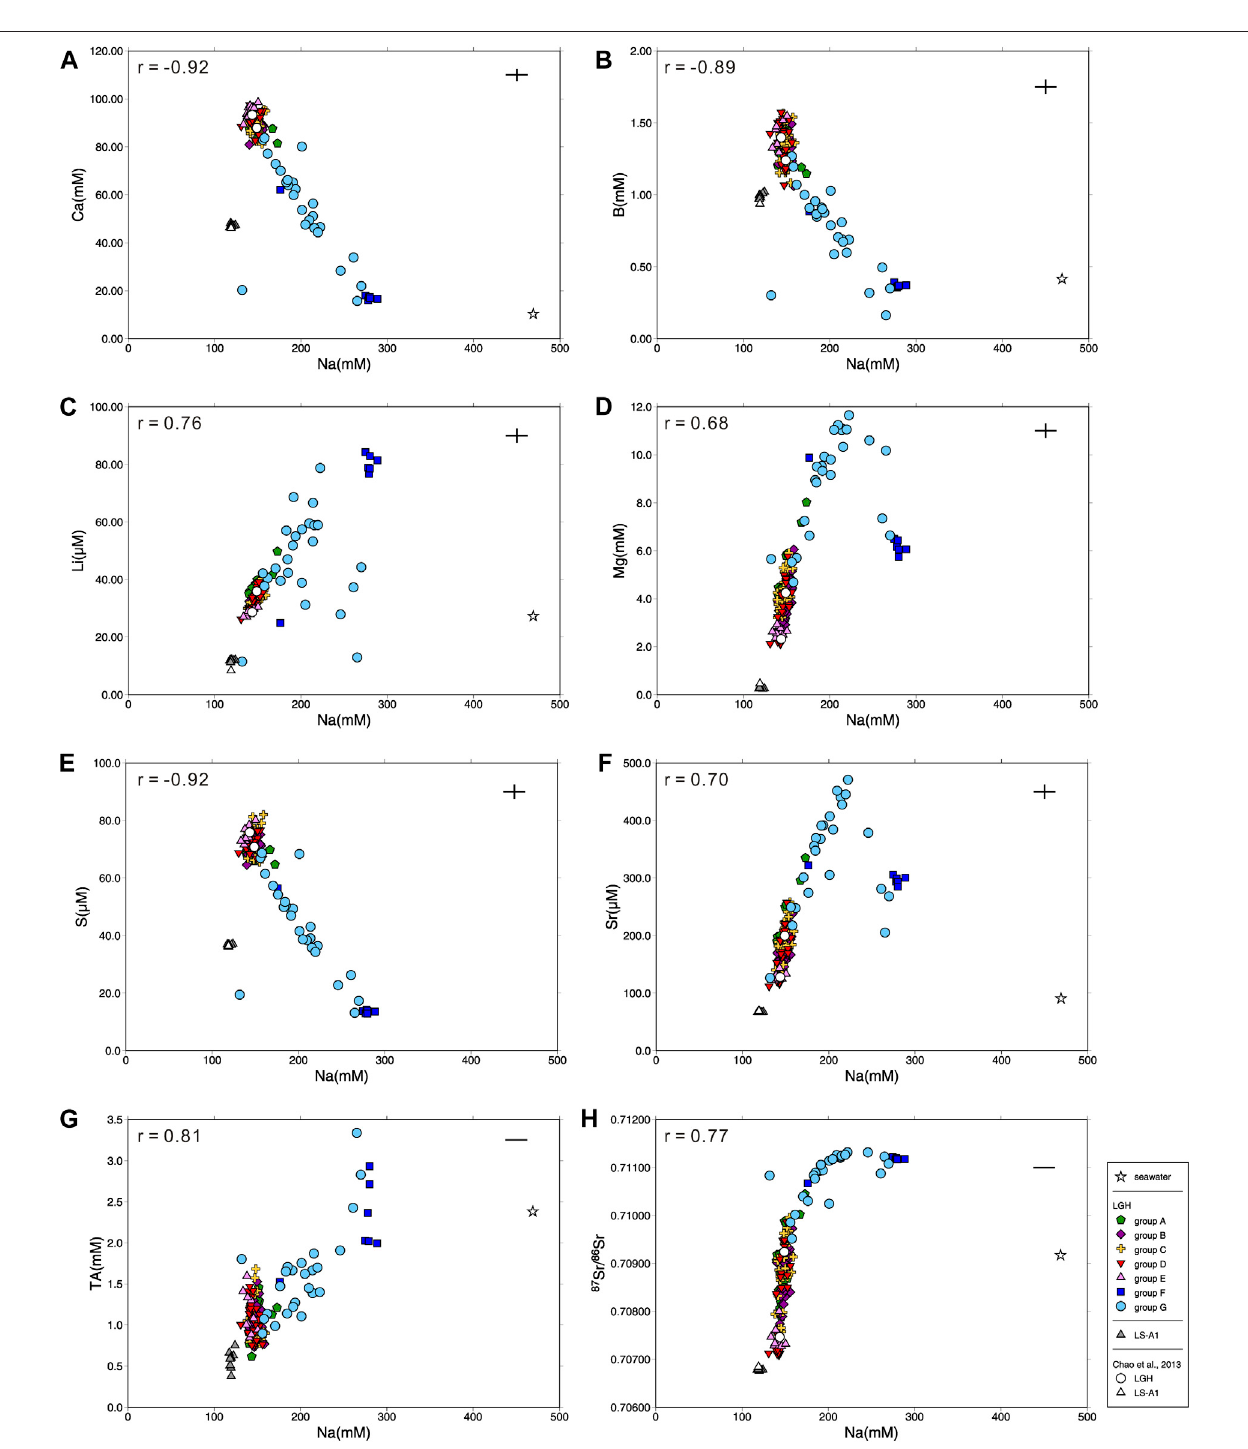
FIGURE3| Plotof (A) Cavs.Na, (B) Bvs.Na, (C) Livs.Na, (D) Mgvs.Na, (E) Svs.Na, (F) Srvs.Na, (G) totalalkalinityvs.Na, (H) 87 Sr/ 86 Srvs.Na, (I) Bvs.Ca, (J) Li vs. Ca, (K) Mg vs. Ca, (L) S vs. Ca, (M) Sr vs. Ca, (N) total alkalinity vs. Ca, and (O) 87 Sr/ 86 Sr vs. Ca for all mud volcano fl uids in this study with Pearson ’ s correlation coef fi cient r and literature results (Chao et al., 2013) for comparison. Seawater composition is shown for reference and the range of the cross denotes the range of the reproducibility (2 σ ).